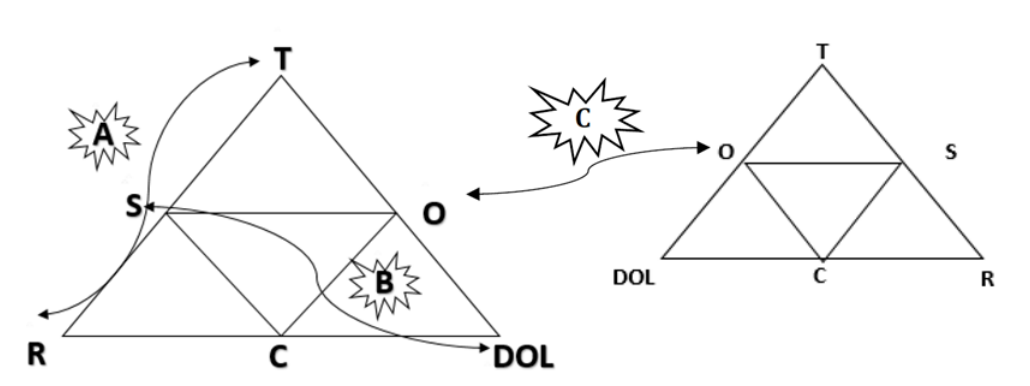
Figure 8 : critical